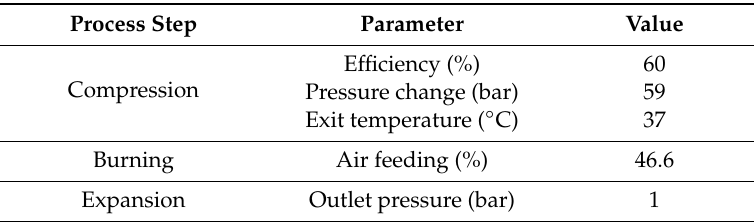
Figure 1. Process flow for electrical energy generation from biogas generated by a sugarcane-based vinasse-fed anaerobic digestion (AD) plant. Table 1. Process parameters of anaerobic digestion.